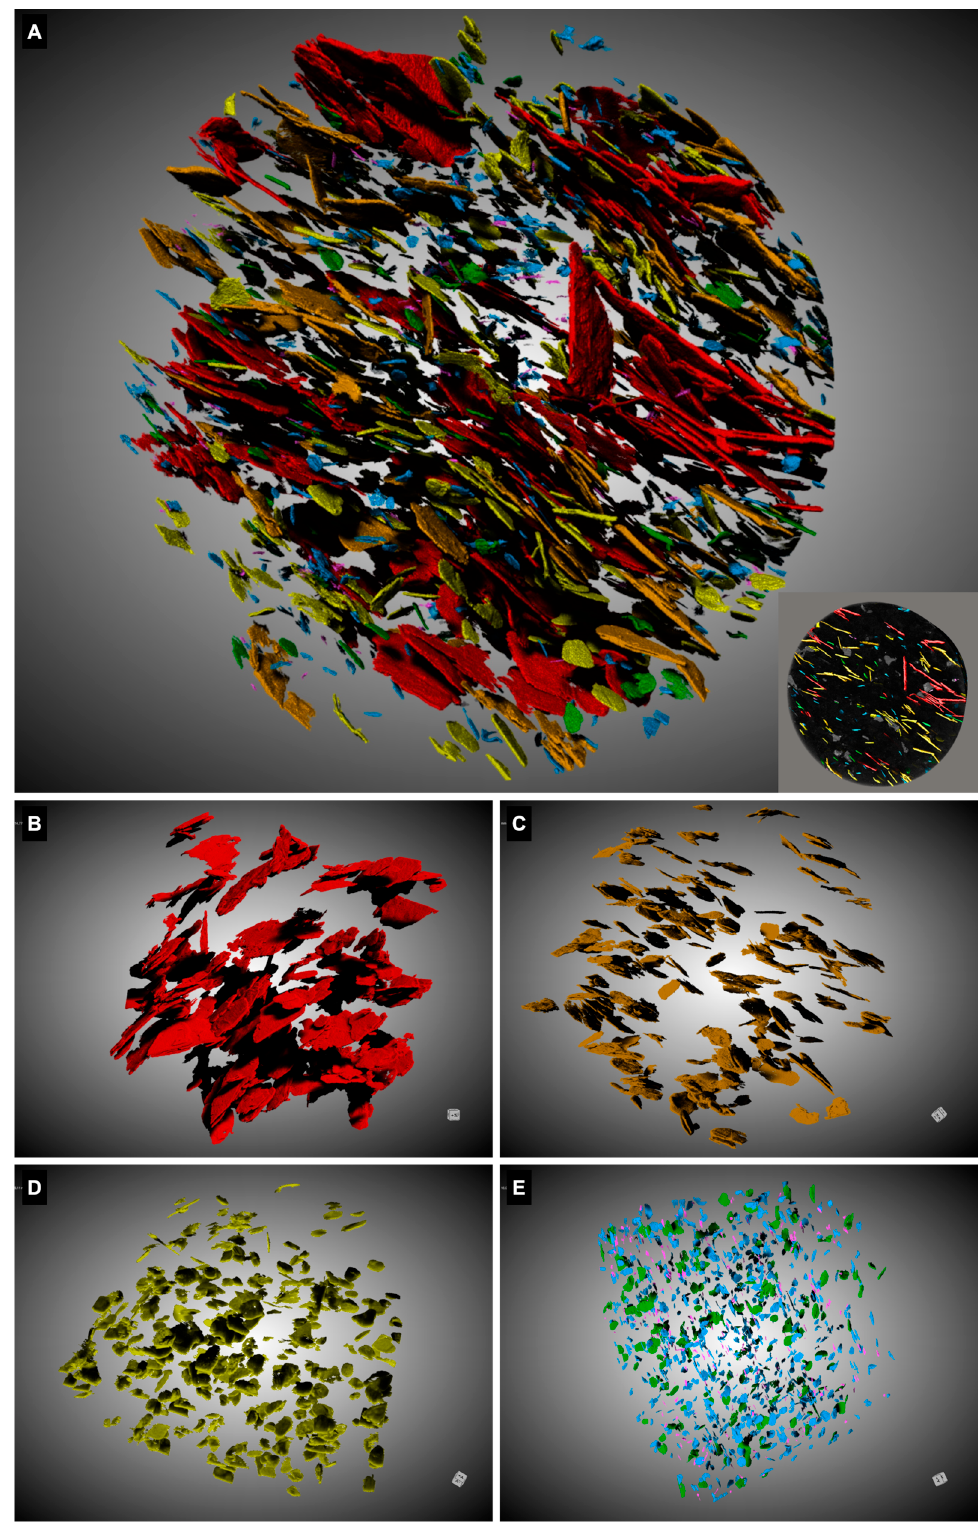
Figure 8. Three-dimensional CT images of the segmented subvolume. ( A ) Volumetric distribution of the graphite flakes in terms of market-related classes comprising super jumbo size (red), jumbo (orange), large flake (yellow), medium flake (green), small flake (blue) and amorphous (violet). The gangue matrix is set fully transparent. A corresponding video is provided in Supplementary Materials. Figure 8B–E individual classes highlighted: ( B ) super jumbo size flakes, ( C ) jumbo flake graphite, ( D ) large flake graphite and ( E ) combined medium flake (green), small flake (blue) and amorphous graphite (violet).